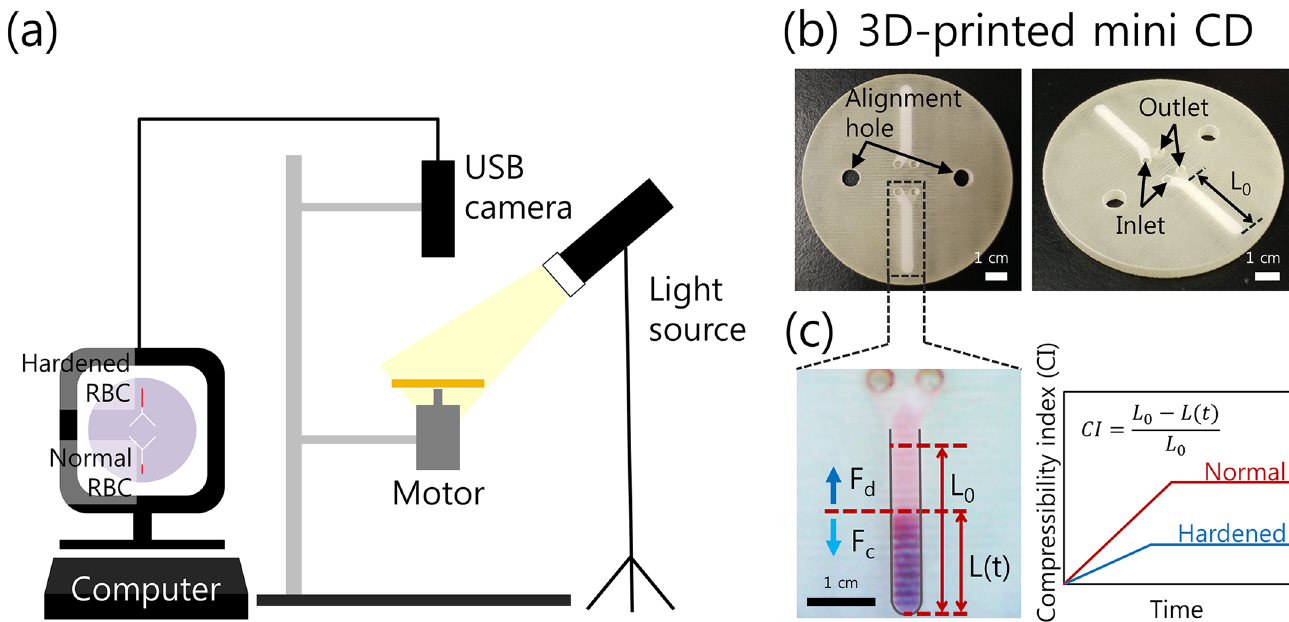
Fig 1. Experimental Setup and working principle. (a) Schematic of the 3D-PMD-based RBC deformability measurement system. (b) Photographs of the 3D-PMD device for measuring RBC deformability. The system contains two channels and two alignment holes that are at opposite sides of the device. The two channels are filled with a normal RBC sample and a hardened RBC sample, respectively. (c) A single unit of a straight channel with one inlet and one outlet and the measurement method of the compressibility index (CI). F d is the drag force and F c is the centrifugal